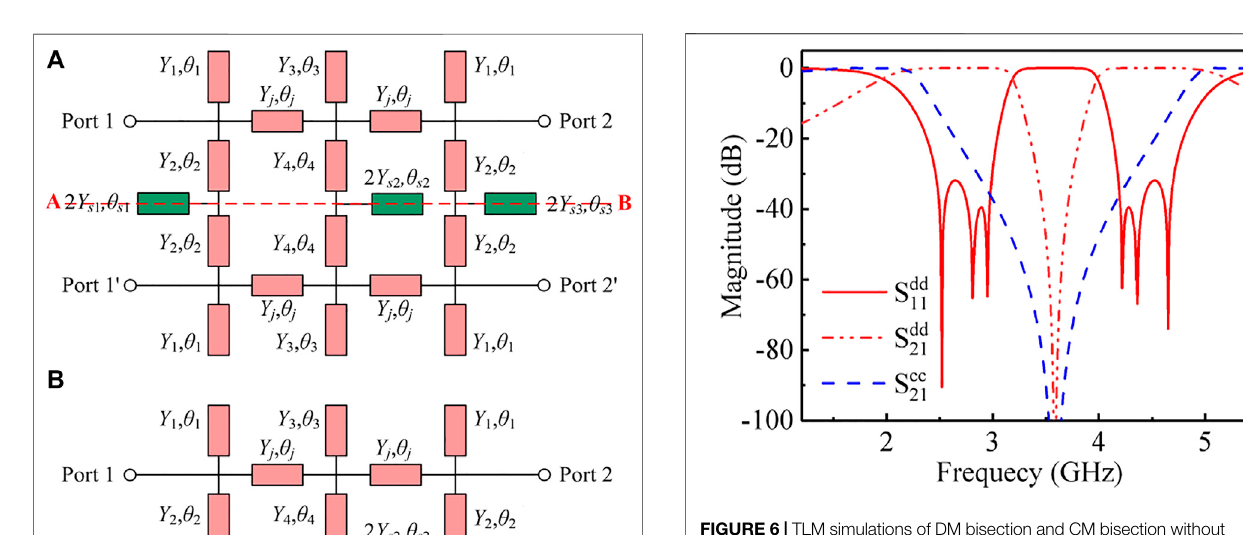
FIGURE 6 | TLM simulations of DM bisection and CM bisection without loaded